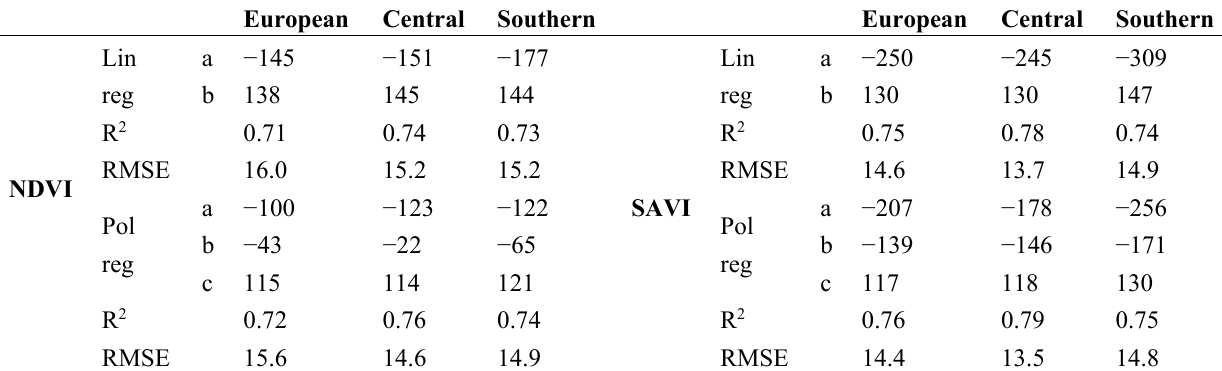
Table 5. Linear and second order polynomial regression models, R 2 and RMSE between reference IS fractions and NDVI/SAVI, and linear regression models, 30 m resolution. European = sub-areas from all cities included in the regression models, Central = sub-areas from Odense, Hamburg, Strasbourg, Exeter and Vienna included in the regression models, Southern = Sub-areas from Barcelona and Nice included in the regression models. European Central Southern European Central